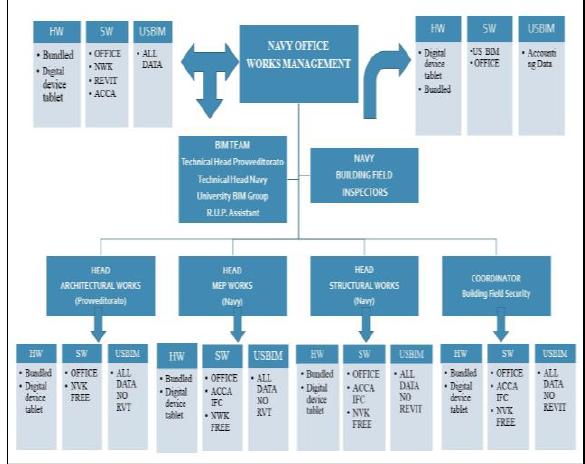
Figure 7 . Construction phases: actors, software, workflows.